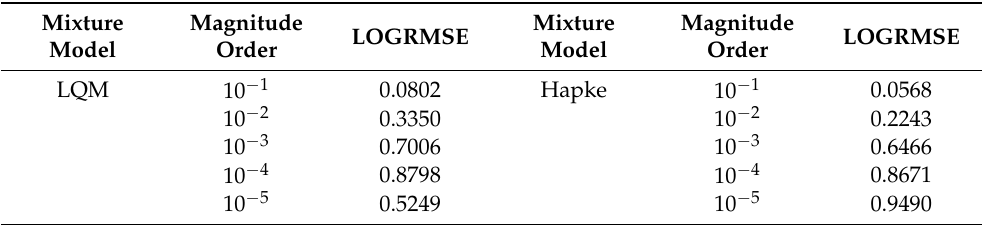
Table 4. LOGRMSE results produced by ENPSM over ten synthetics images generated based on LQM and Hapke’s equations.